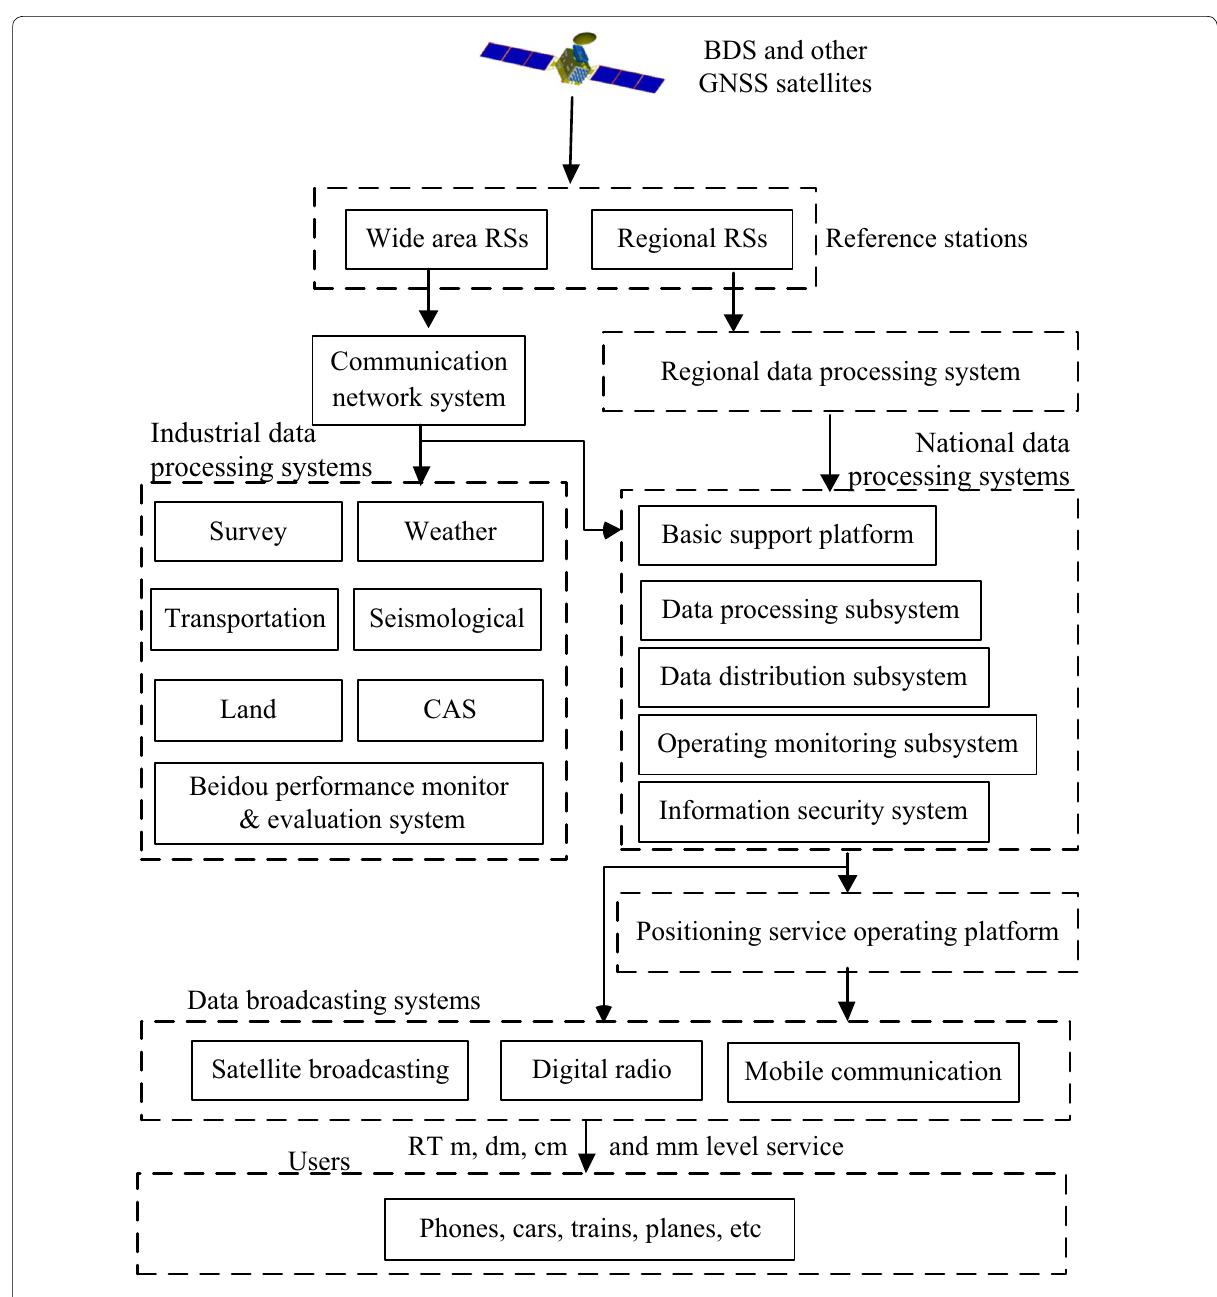
Fig. 8 Workflow of